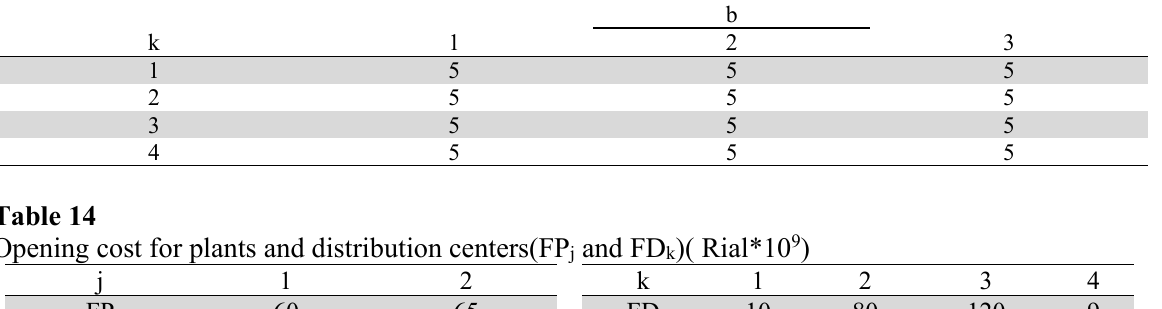
Holding cost for final products in distribution centers(h b k ) (Rial×10 6 )